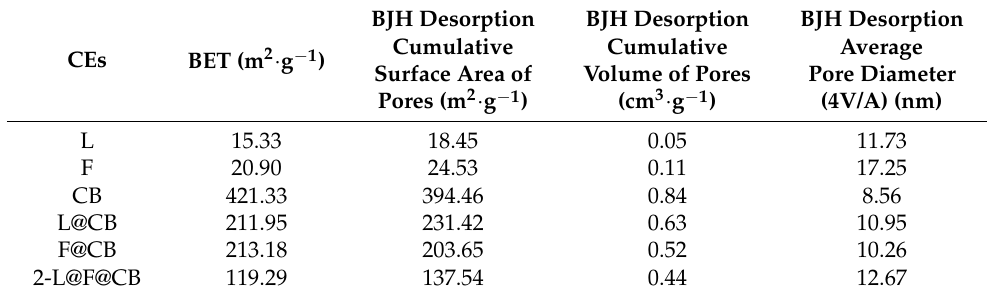
Figure 3. Nitrogen adsorption–desorption isotherms ( a , b ), pore size distributions of L, F, CB, L@CB, F@CB and 2-L@F@CB ( c , d ). Table 1. BET and BJH parameters for L, F, CB, L@CB, F@CB, and 2-L@F@CB.